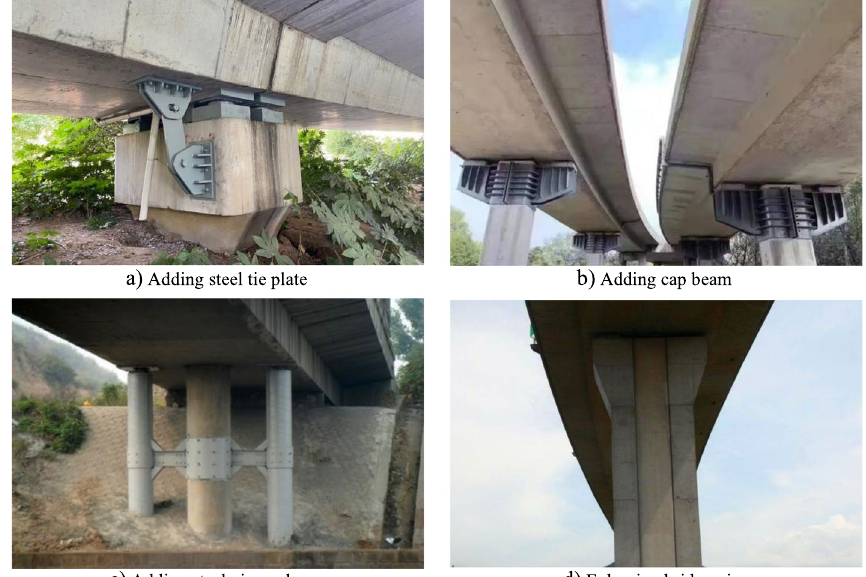
Fig. 24 Retrofit options against